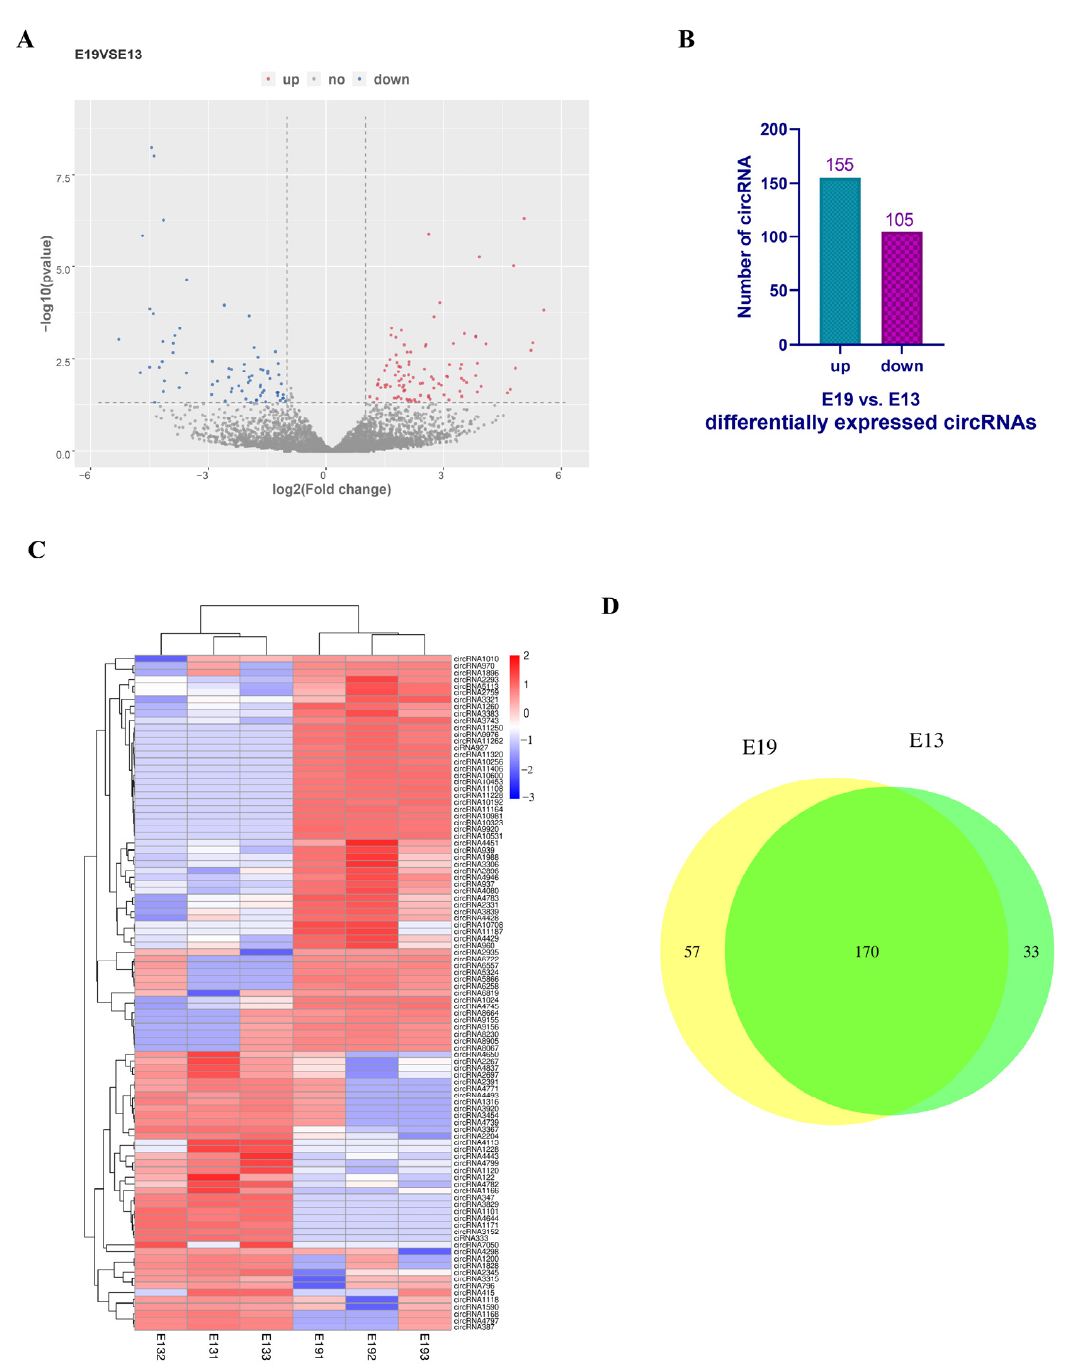
Figure 2. Circular RNAs are expressed differently in two stages of duck embryonic breast muscle development. ( A ) Volcano plot of circular RNAs expressed at E19 vs. E13. The red dots represent upregulated circular RNAs; the blue dots represent downregulated circular RNAs; the grey dots represent no difference in expression. ( B ) Numbers of upregulated and downregulated circular RNAs. ( C ) Heat map of the top 100 differentially expressed circular RNAs at E19 vs. E13 in the pectorales. ( D ) Venn diagrams of differentially expressed circular RNAs at E19 vs.